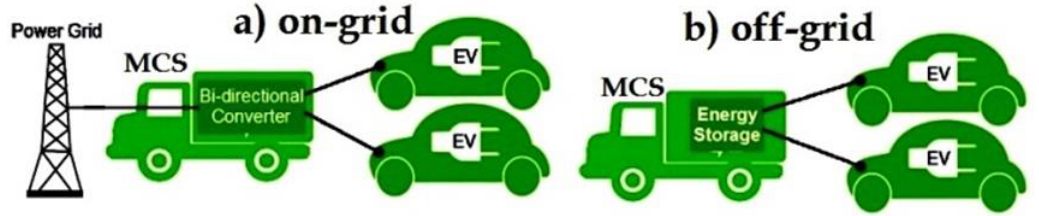
Figure 9. Mobile charging station. ( a ) on-grid charging mode; ( b ) off-grid charging mode